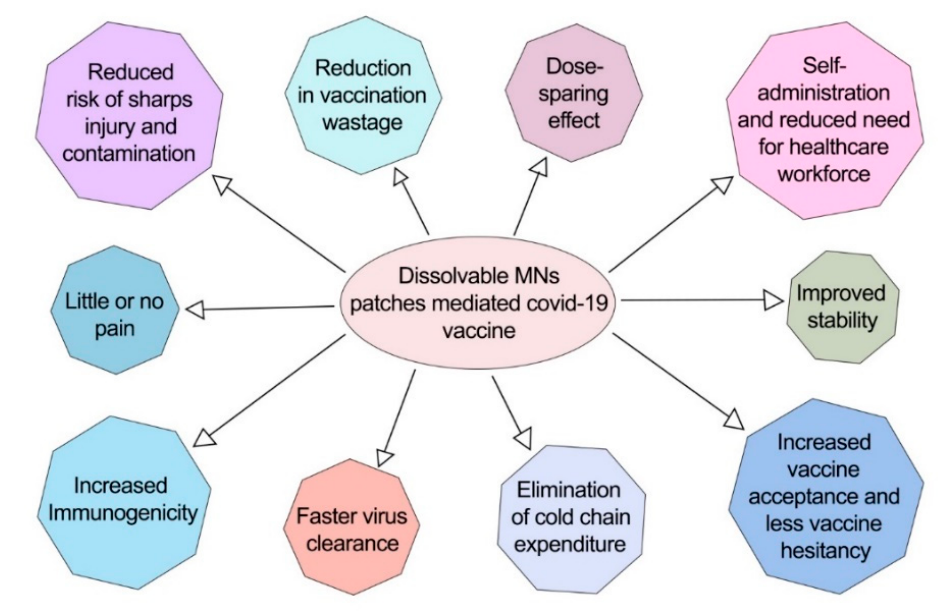
Figure 11. Advantages of dissolvable MN-mediated COVID-19 vaccine (information taken from [329]). Table 7. Research works carried out to establish MN-mediated vaccine delivery.